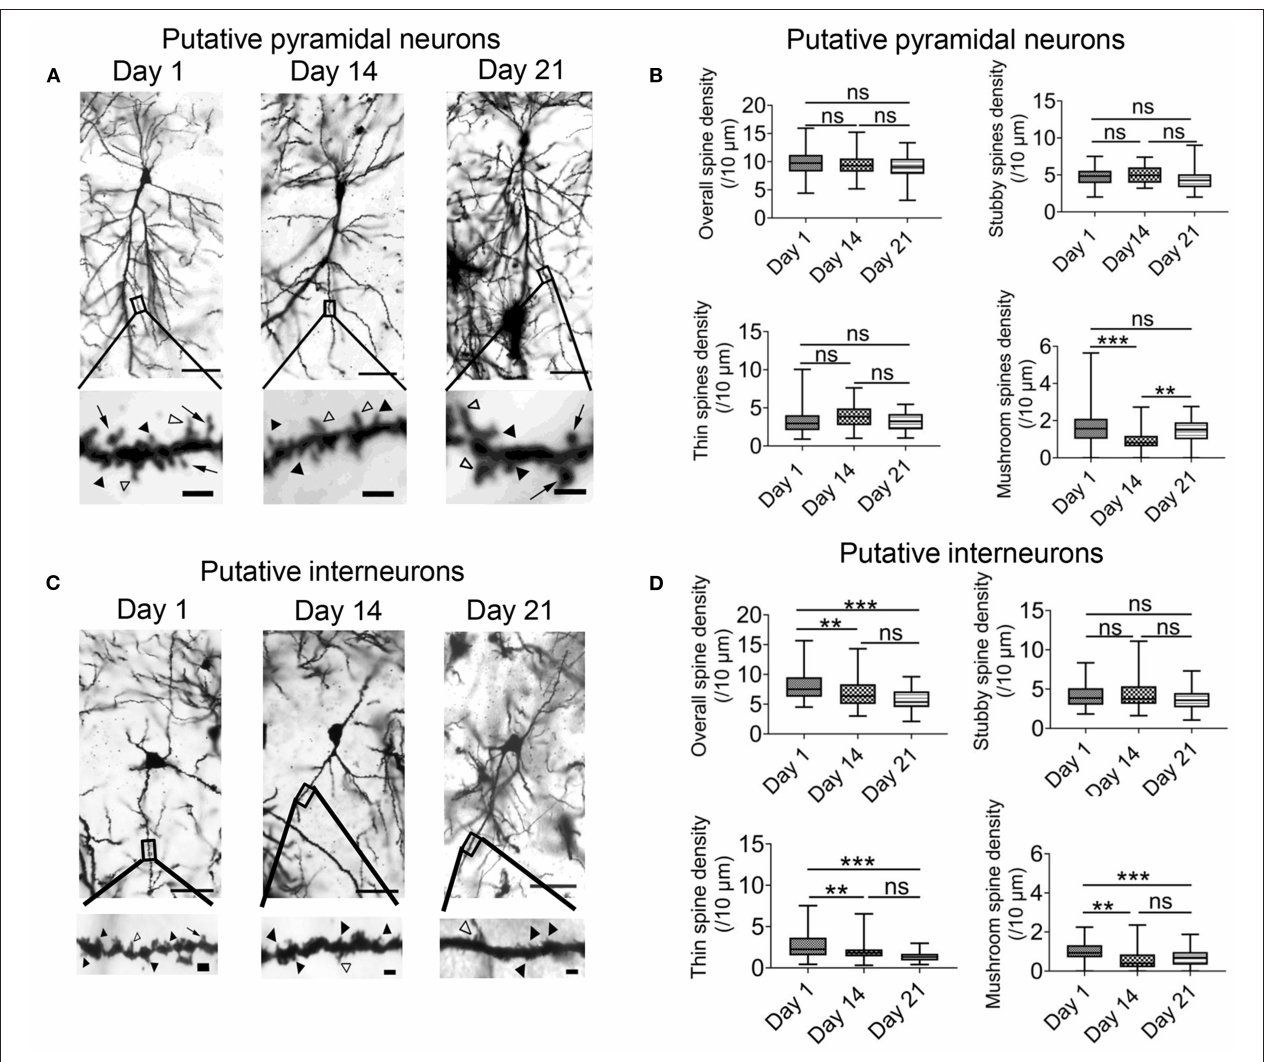
FIGURE 6 | Chronic intermittent hypoxia (IH) reduces mature spine formation of CA1 pyramidal neurons and interneurons. (A) Typical morphologies of individual pyramidal neurons in CA1 region revealed by Golgi staining on day 1, 14 and 21. Scale bar: 50 µ m. The higher magnification pictures shown in the lower panels allowed quantification of spine density and classification of individual spines. Black arrowheads indicate stubby spines; white arrowheads indicate thin spines; arrows indicate mushroom spines Scale bar: 4 µ m. (B) Quantification analysis from 54 dendrites revealed no significant difference between day 1, 14 and 21 in terms of overall spine density (top left), stubby spine density (top right) and thin spine density (bottom left). However, the density of the mushroom spine was significantly altered (bottom right). Meanwhile, post-hoc Newman-Keuls’s test revealed mushroom spine density was decreased significantly in 2 weeks IH treatment, which could recover on day 21 (right panel). *** P < 0.001. (C) Typical morphologies of individual interneurons in CA1 region revealed by Golgi staining on day 1, 14 and 21. Scale bar: 50 µ m. Higher magnification pictures are shown in the lower panels. Scale bar: 4 µ m. (D) Quantification of data from 45 dendrites showed that there was significantly difference in the overall spine density (top left), thin spine density (bottom left) and mushroom spine (bottom right) except stubby spine density (top right). Post-hoc Newman-Keuls’s test revealed clear reduction of overall spine density after 2 weeks of IH treatment, compared with day 1, as well as the densities of thin spine and mushroom spine. These changes were not recoverable even after 1 week of normoxia treatment, ** P < 0.01, *** P <